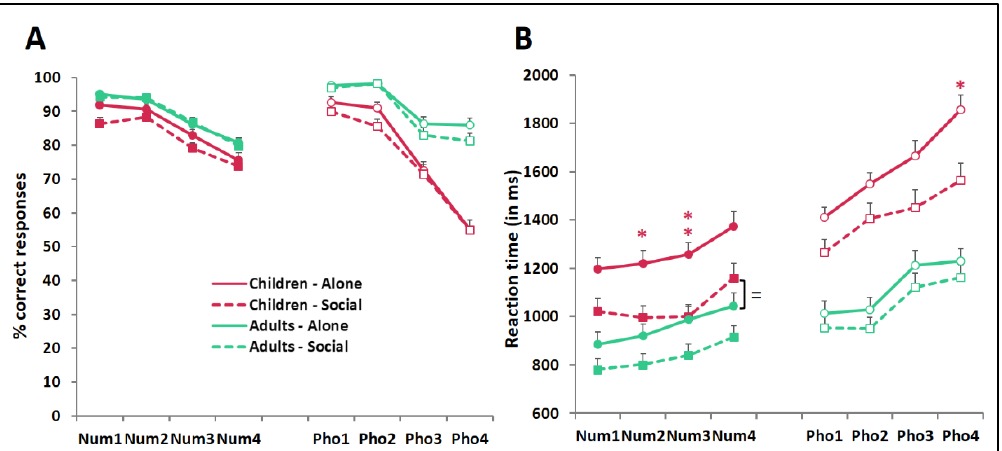
Figure 2. Accuracy ( A ) and reaction time ( B ) for numerosity (Num) and phonological (Pho) comparisons of increasing difficulty (Levels 1–4 for both Num and Pho) in children (pink) and adults (green) tested with (Social, dashed lines) vs. without (Alone, solid lines) a peer. Data points are means + SEM. Symbols denote results from Student’s t -tests with the Bonferroni adjustment for multiple comparisons the asterisks indicate differences between the Social and Alone conditions (* p < 0.05, ** p < 0.01), the = sign underscores the lack of difference between the reaction times of children tested with a peer and those of adults tested alone for all four Num difficulty levels.